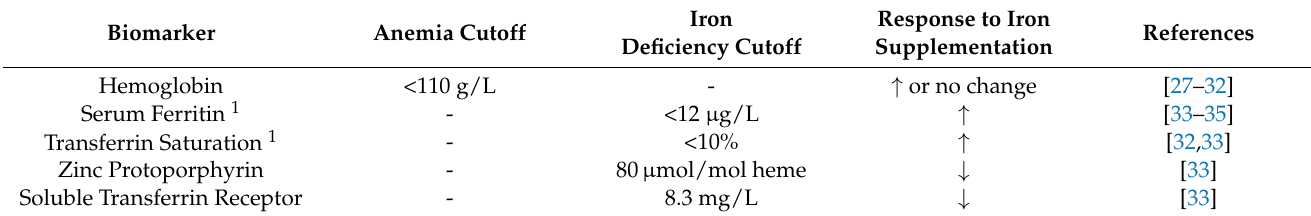
Table 1. Common biomarkers for defining anemia and iron deficiency in